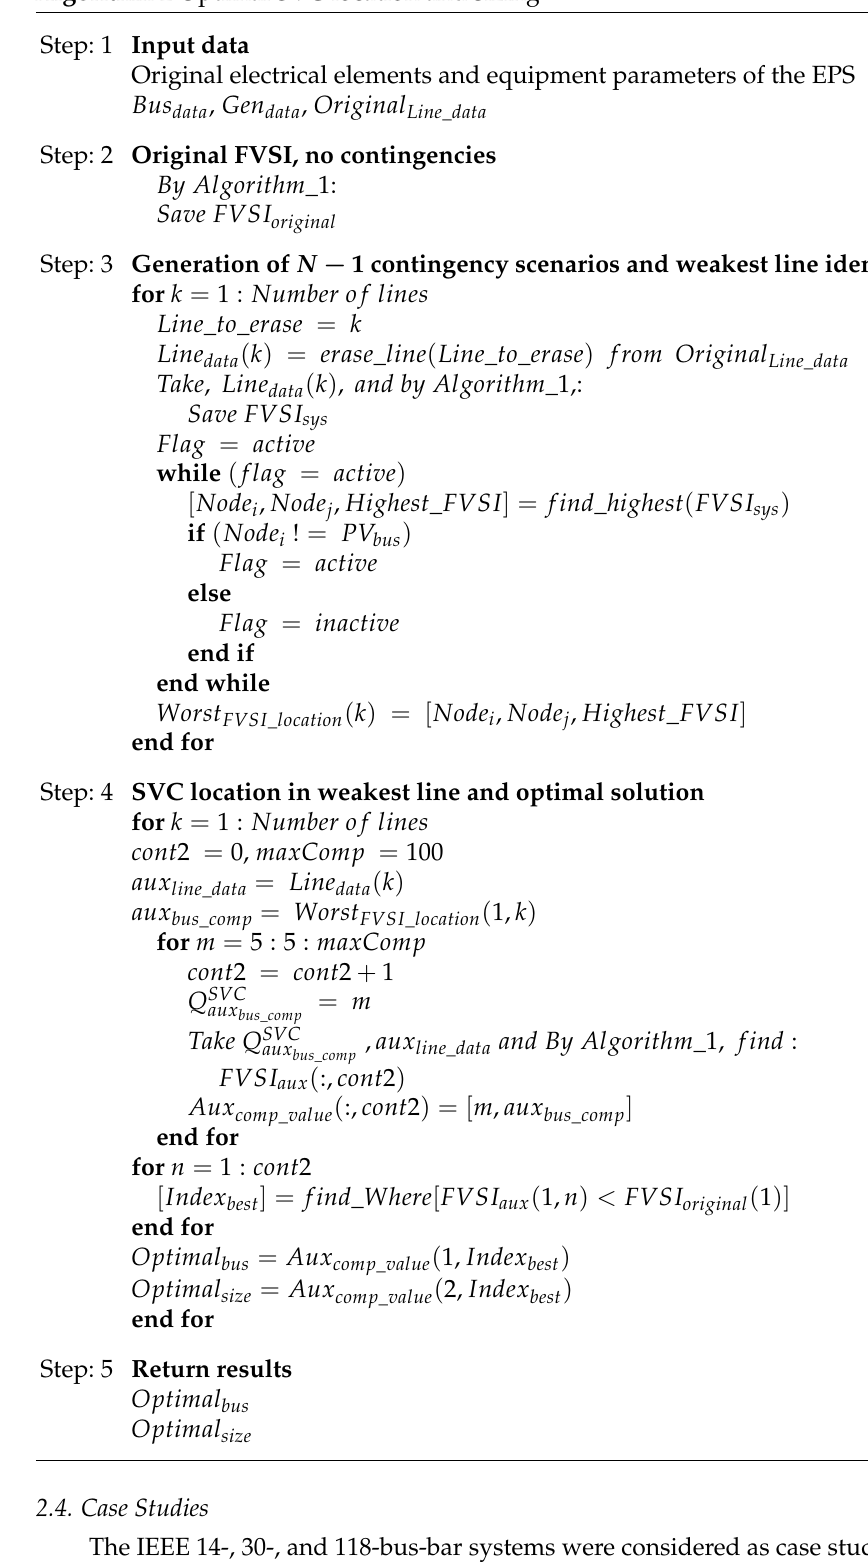
Algorithm 2 Optimal SVC location and